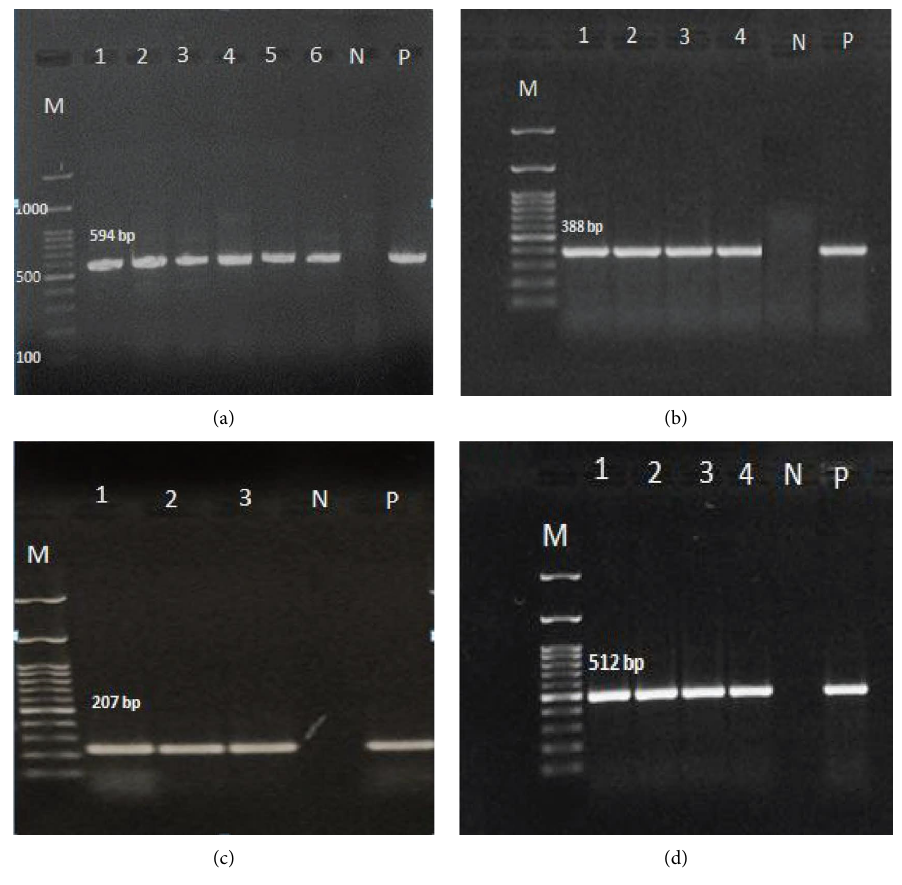
Figure 1: Gel electrophoresis of PCR products of (a) qnr B (594bp), (b) qnr S (388bp), (c) oqx A (207bp), and (d) oqx B (512bp) in qnr-positive Klebsiella pneumoniae strains isolated from hospitalized patients in Hamadan hospitals. Lane M: 100bp DNA size marker, lane P: positive control, and lane N: negative control.